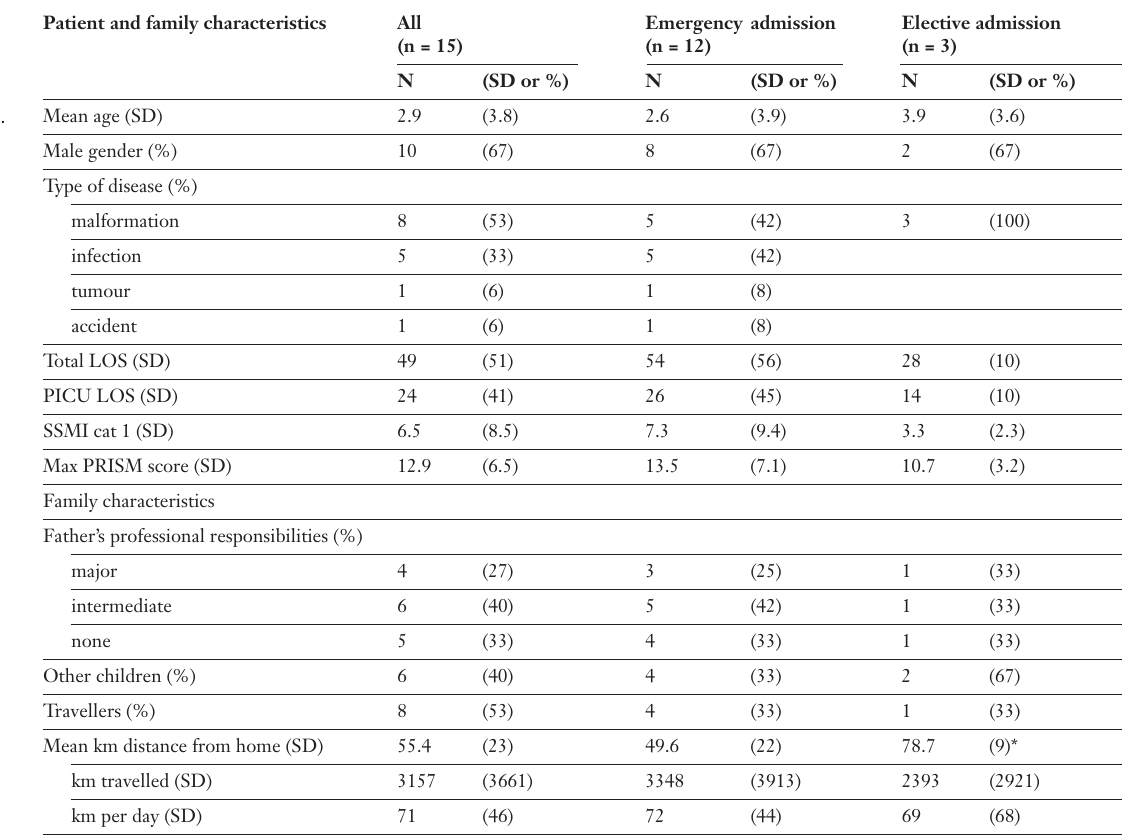
Table 2 Patient and family characteristics, for the whole group and by type of admission.